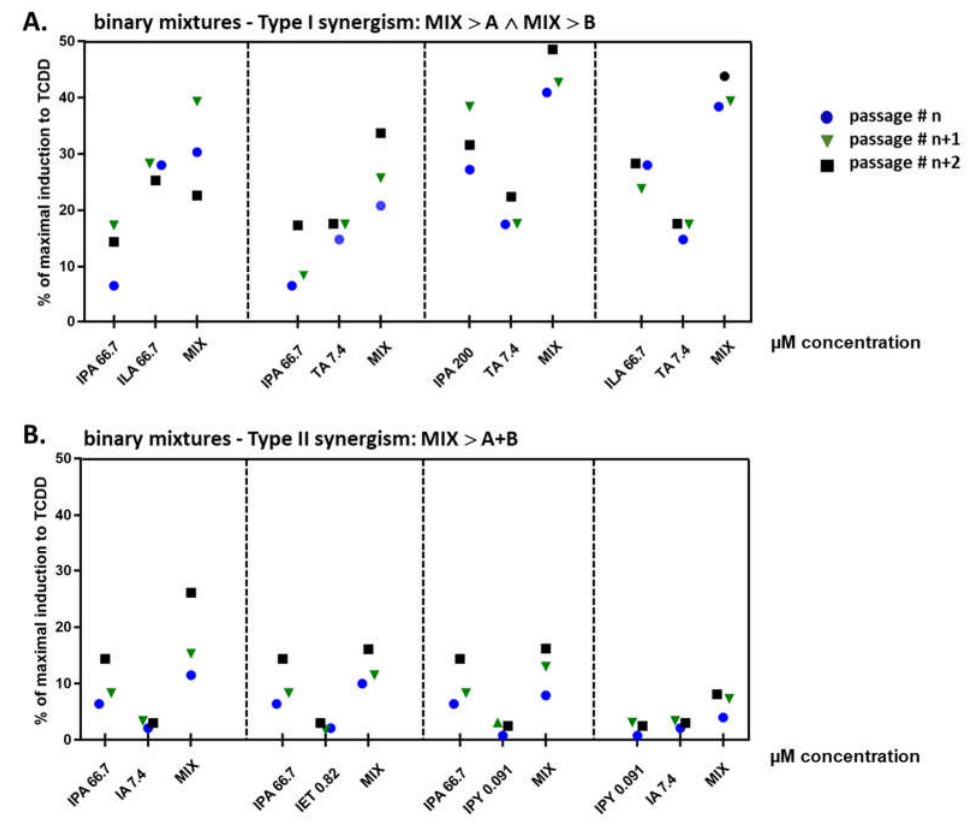
Figure 4. The induction of CYP1A1 by selected MICTs and their binary combinations. ( A ) Type I synergism, where the efficacy of the binary mixture is higher than the effect of each compound alone; ( B ) Type II synergism, where the efficacy of the binary mixture is higher than the sum of the efficacies of two single compounds. AZ-AHR cells were incubated with vehicle (DMSO; 0.2% v / v ), TCDD (20 nM), or MICTs alone or in binary combinations for 4 h. The levels of CYP1A1 mRNA were determined by qRT-PCR and are expressed as a percent of induction by TCDD. Each dot represents one independent experiment. The experiments were performed in technical triplicates and three biological replicates at